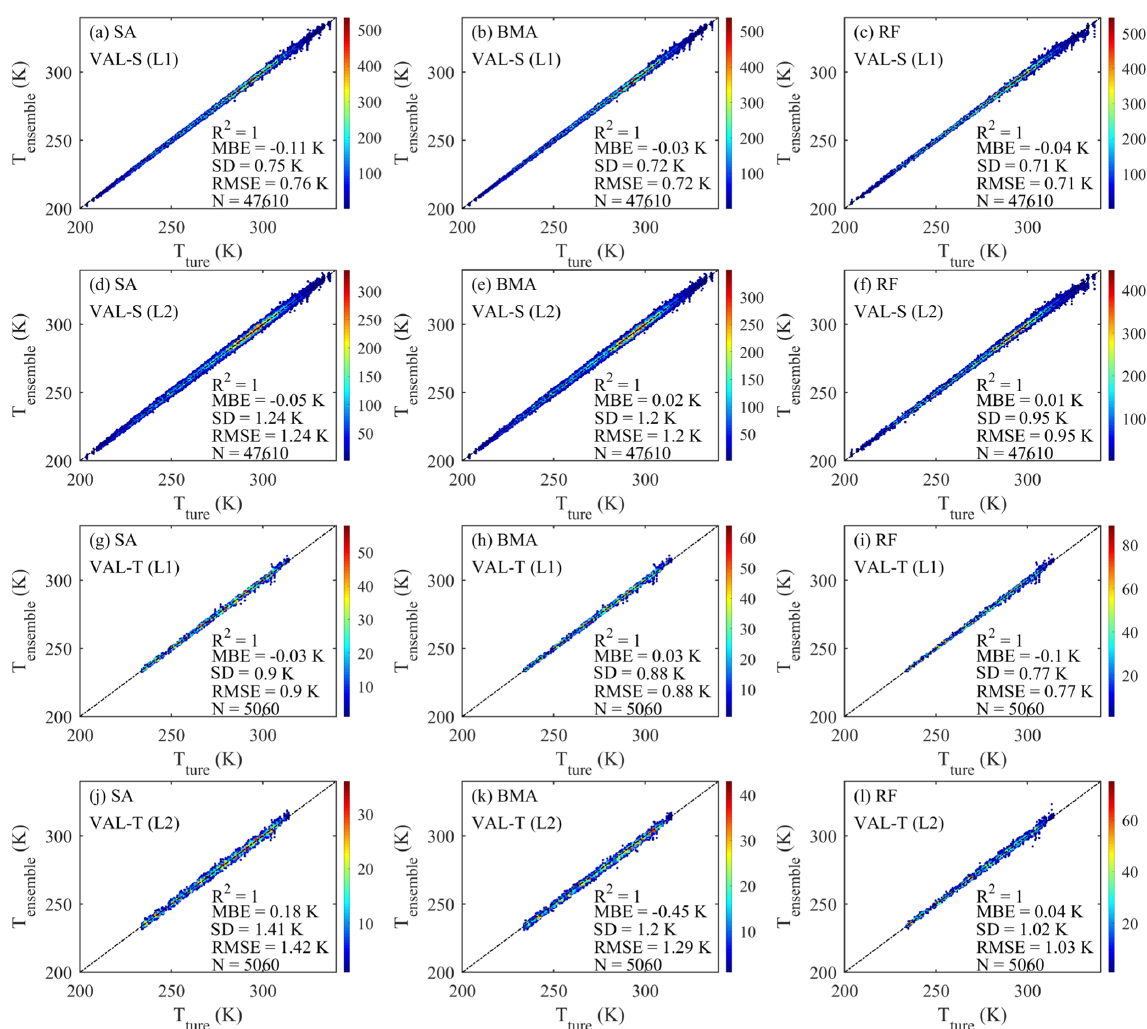
Figure 7. LST retrieved with the three ensemble methods for NOAA-14 against true LST. Results are based on simulation datasets VAL-T and VAL-S with added Gaussian noise (uncertainty levels L1 and